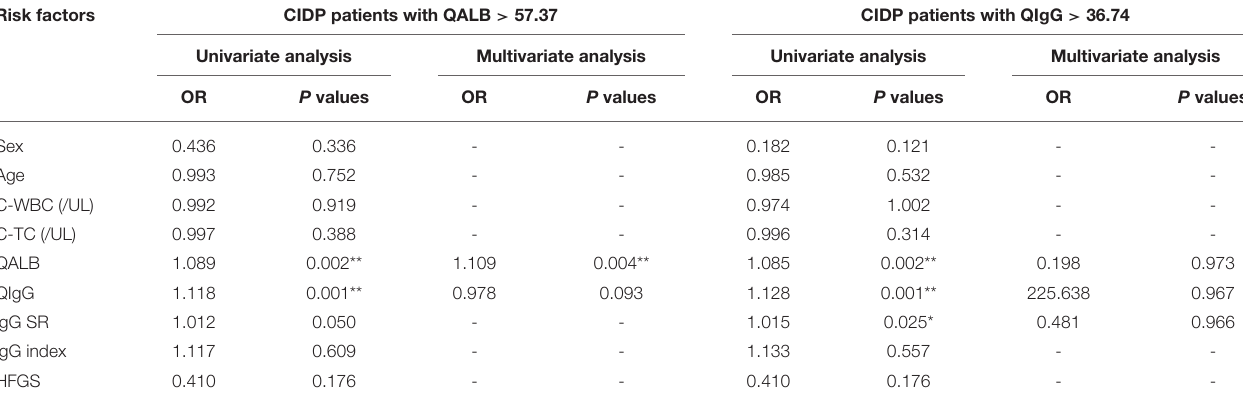
TABLE 6 | Logistic regression analysis of the risk factors for CIDP in patients with QALB > 57.37 or QIgG > 36.74. Risk factors CIDP patients with QALB > 57.37 CIDP patients with QIgG > 36.74 Univariate analysis Multivariate analysis Univariate analysis Multivariate analysis P values OR P values OR P values